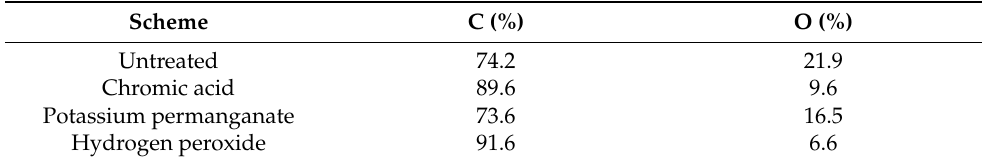
Table 3. Elemental analysis of UHMWPE after oxidation on the surface [40]. Scheme C (%)